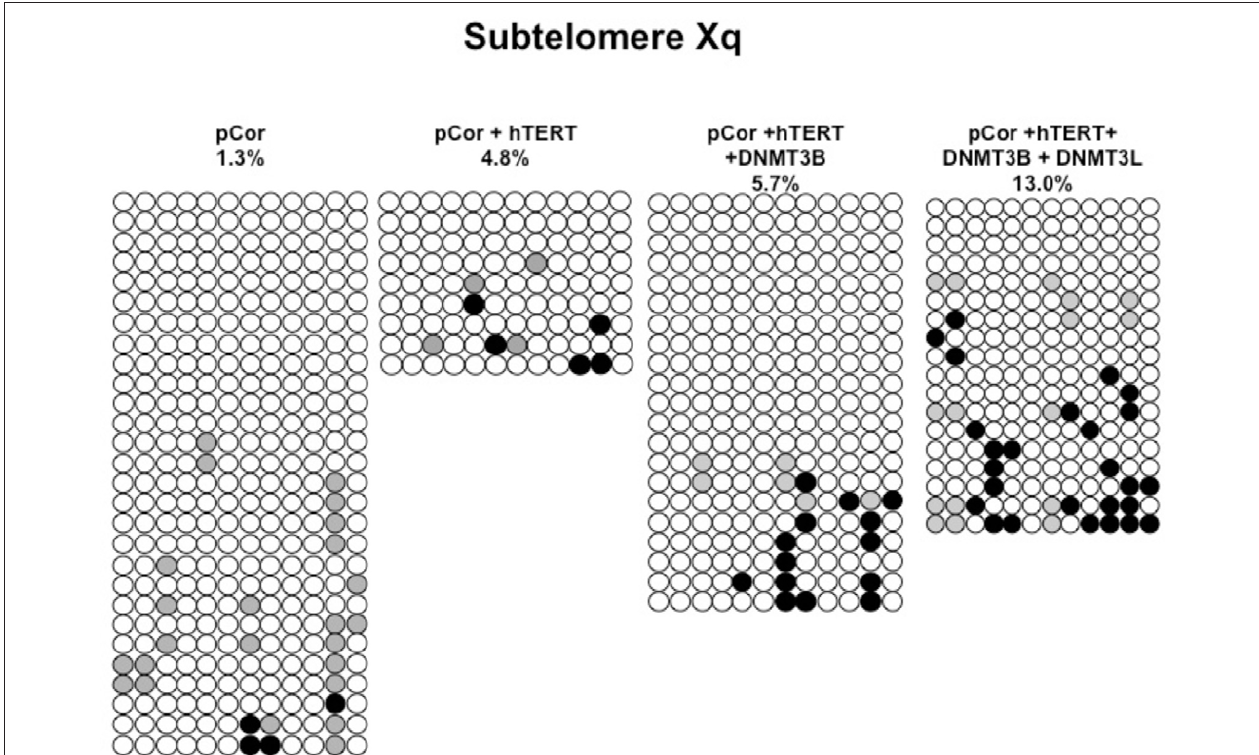
FIGURE A9 | Bisulfite analysis of subtelomeric region Xq. Bisulfite sequence analysis was carried out for a region in subtelomere Xq in pCor, pCor + hTERT, pCor + hTERT + DNMT3B 1 and pCor + hTERT + DNMT3B 1 + DNMT3L fibroblasts. The analyzed region contains 12 CpG sites. White circles represent unmethylated CpG